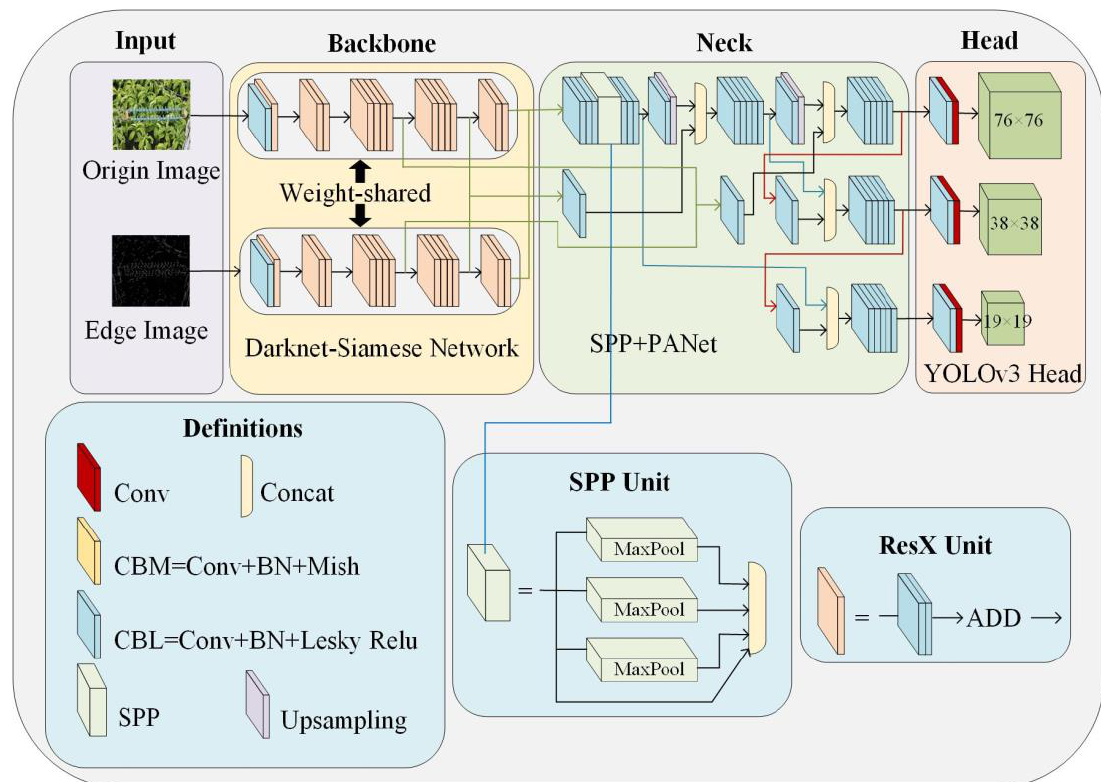
Figure 2. The insulator detection model Siamese ID-YOLO includes the backbone, neck, head, and Siamese network. The backbone extracts feature information. The neck can solve the problem of the too significant size difference between the detected objects. The head used to predict the target category and box position is the last part of a detector. Based on the Siamese network, input edge information as gain information into Siamese ID-YOLO. Algorithm 1. The training process of Siamese ID-YOLO. Algorithm 2. The testing process of Siamese